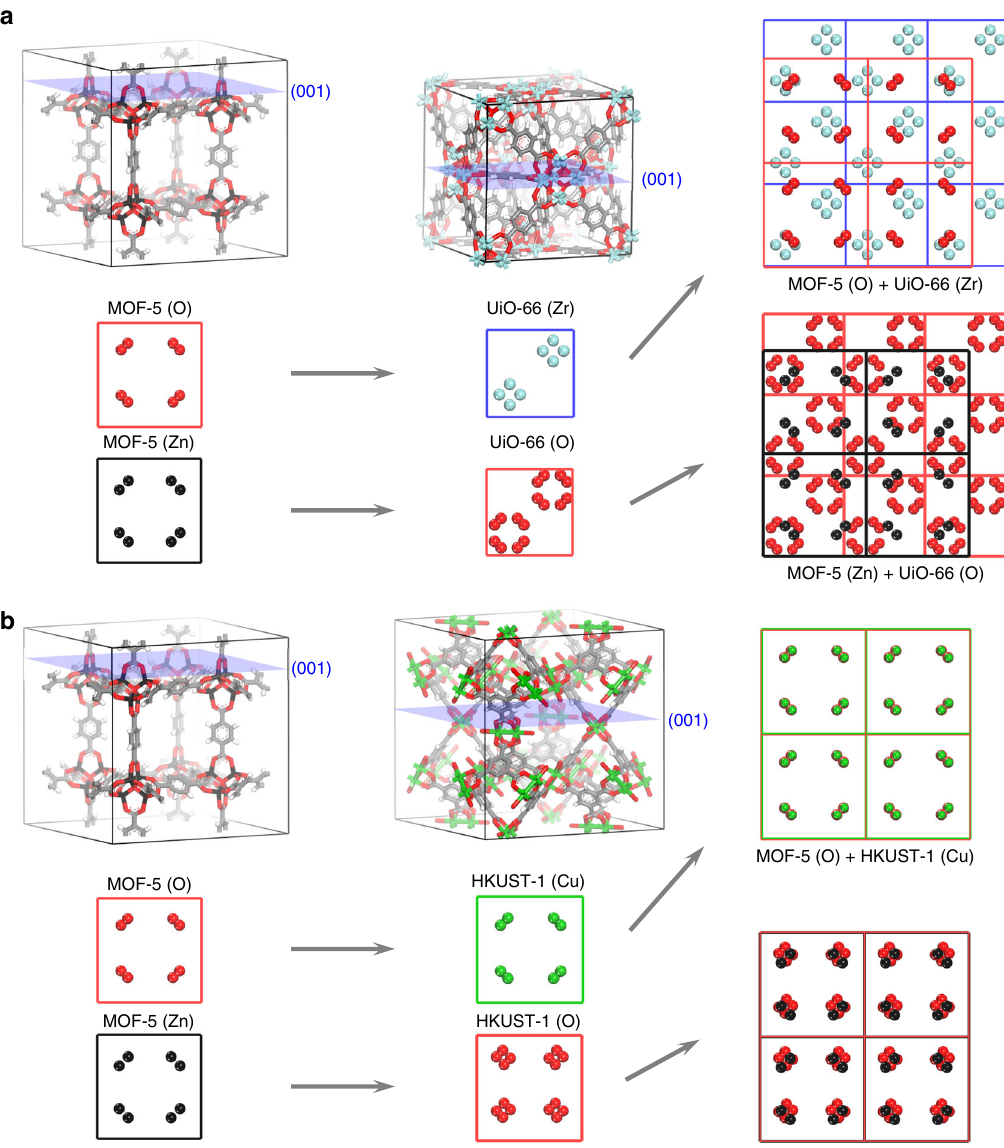
Fig. 1 Illustrative example showing the chemical connection points matching. a Examples of MOF-5 and UiO-66 along the (001) plane. Black, blue, and red circles represent the zinc, zirconium, and oxygen atoms, respectively. b Similar to a but for HKUST-1 with green circle representing the copper